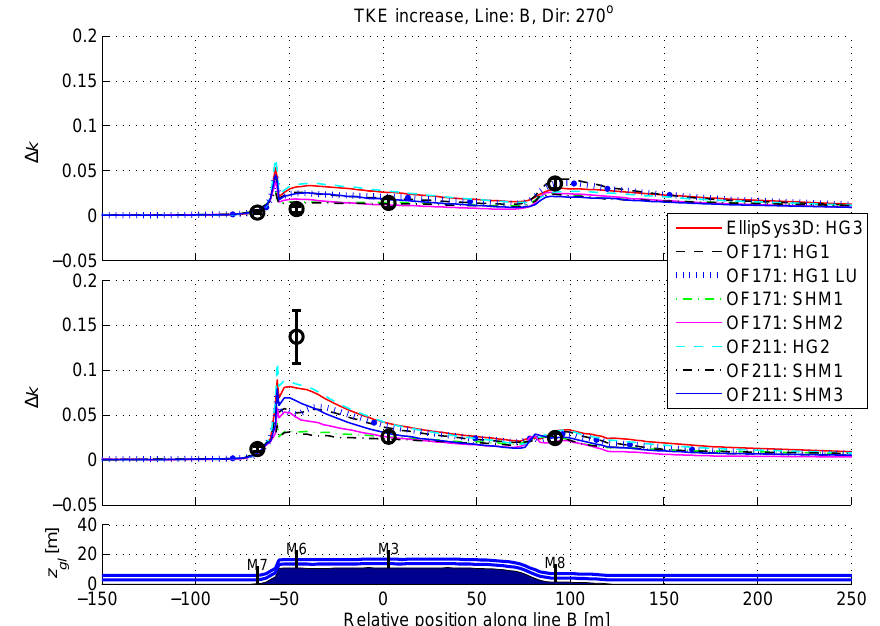
Figure 10. Bolund Hill: turbulent kinetic energy along line B. Uppermost panel: 5ma.g.l.; middle panel: 2ma.g.l.